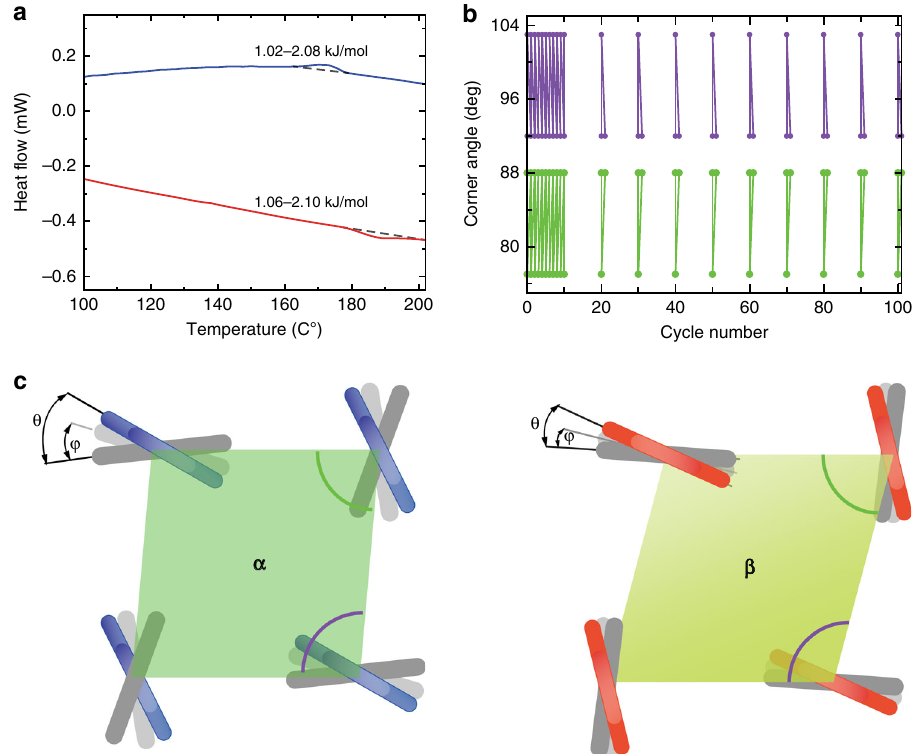
Fig. 3 Reversibility of the shape deformation. a The DSC curve during the α - to β -phase transformation. The dashed lines are the baseline for the integration of the exothermic and endothermic peak. The same integral value indicates a completely reversible phase transition. Source data are provided as a Source Data fi le. b The reversibility of the macroscopic deformation, as measured by the reversible changes of the corner angles of the crystal, from 92° to 103° and from 88° to 77°, respectively, for over 100 heating/cooling cycles. c Schematic diagram of the molecular conformational changes during the phase transition. Rotation of the phenyl rings (gray segments) with respect to the rigid center part of the molecule (red and blue segments) leads to different corner